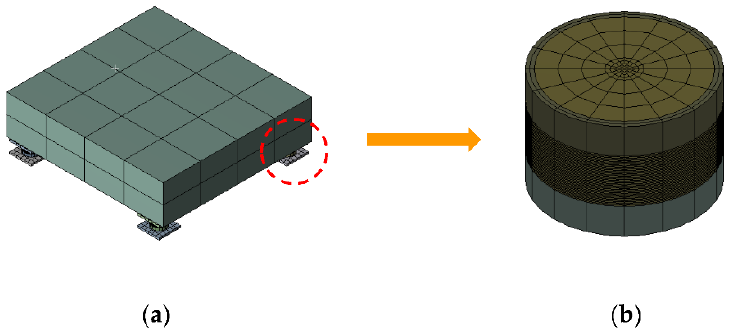
Figure 7. FE analysis models for simulation of dynamic test: ( a ) isolated dummy mass model; ( b ) middle portion of LRB model. Table 3. Comparison of designed LRB natural modes with analysis results. Mode No.